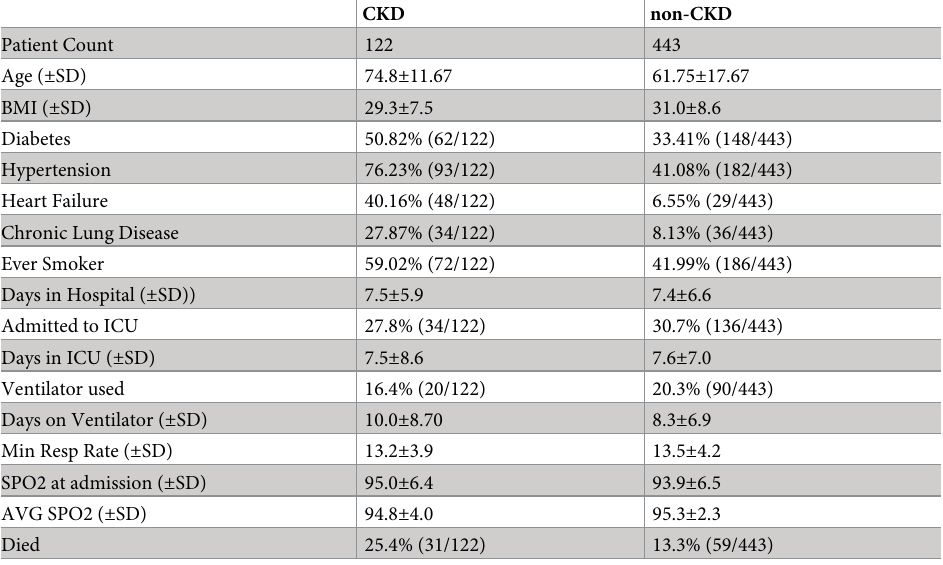
Table 3. Clinical outcomes for hospitalized patients with known history of chronic kidney disease.